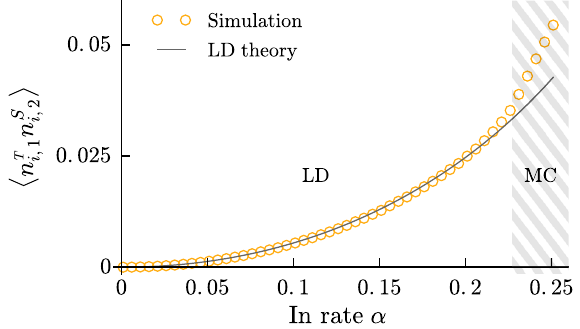
FIG. 13. Second moment h n T i; 1 n S i; 2 i of occupations of different species at the first two lattice sites as predicted by our theory (lines) and stochastic simulations (symbols) for the special case δ ¼ 1 = 2 and W ¼ 2 . Deviations between theory and simulation only occur close to the phase transition at α ≈ 0 . 22